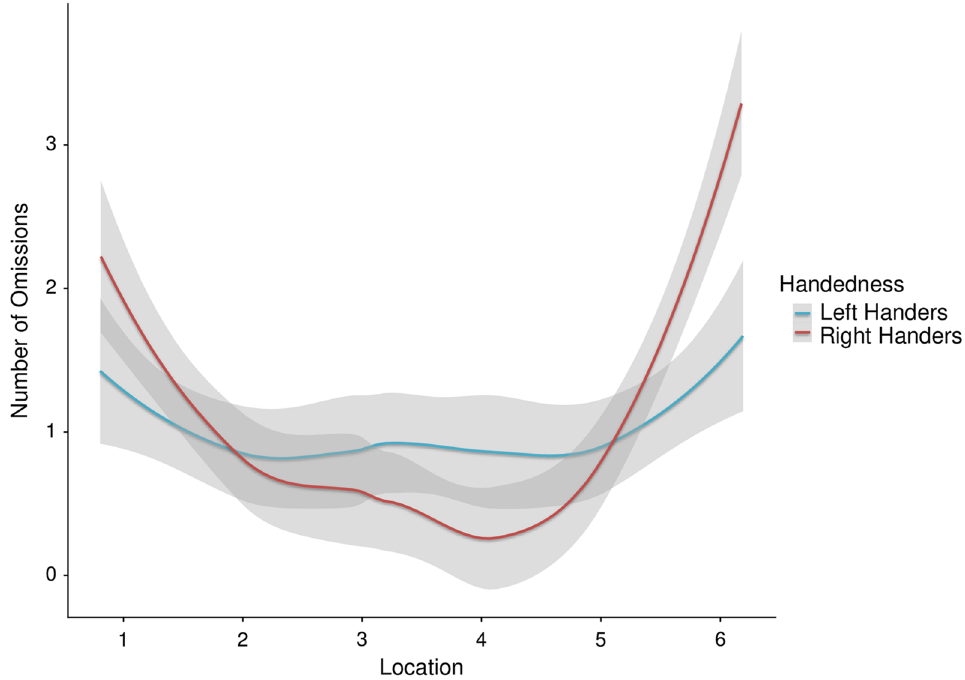
Figure 4. A handedness by location interaction revealed right handers show an increased number of omissions in the rightmost periphery compared to left handers. Smoothed means and shaded area representing 95% confidence intervals are displayed.